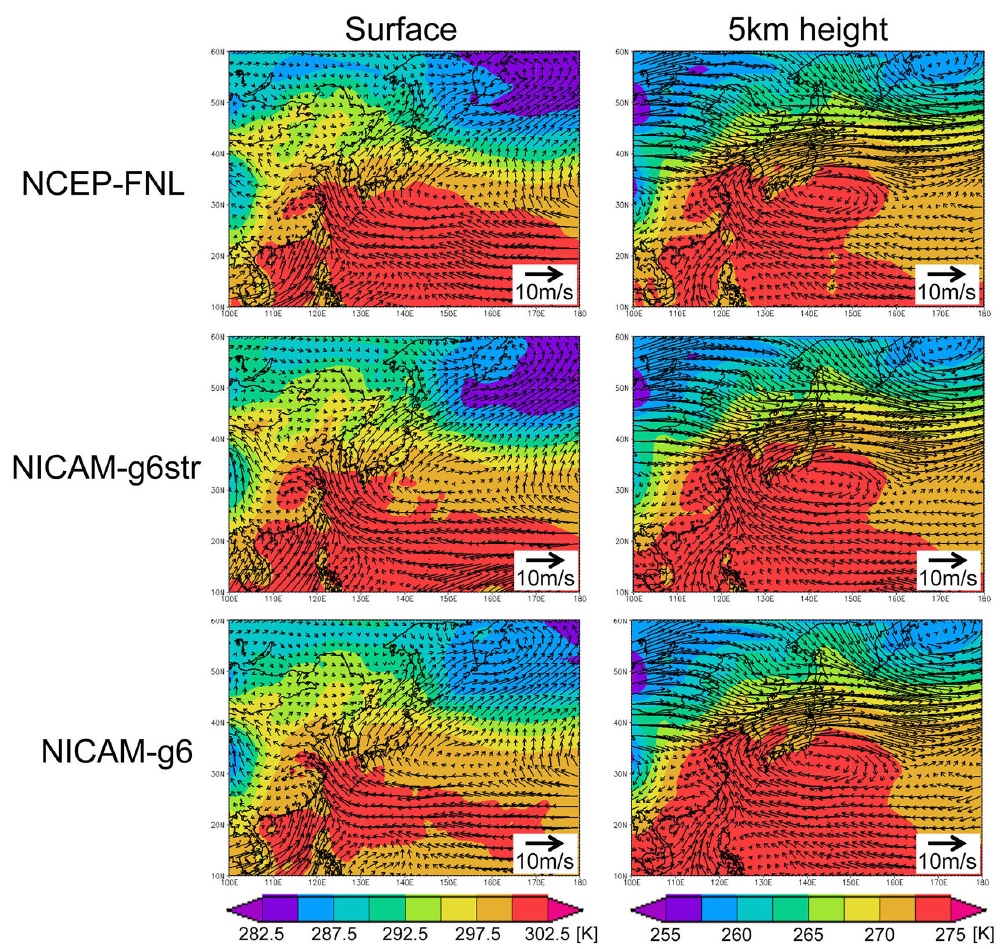
Figure 3. Horizontal distributions of temperature and winds in August averages at the surface and the model height of approximately 5km over the Asia region using reanalysis data from NCEP-FNL, simulation by NICAM-g6str, and simulation by